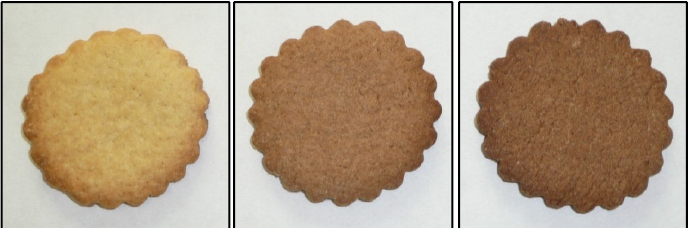
Figure 1. Biscuits enriched by increasing levels of almond skins. From left to right: Control = biscuits prepared without adding almond skins; biscuits prepared by adding 10 g of almond skin powder per 100 g of wheat flour (AS10); biscuits prepared by adding 20 g of almond skin powder per 100 g of wheat flour (AS20).